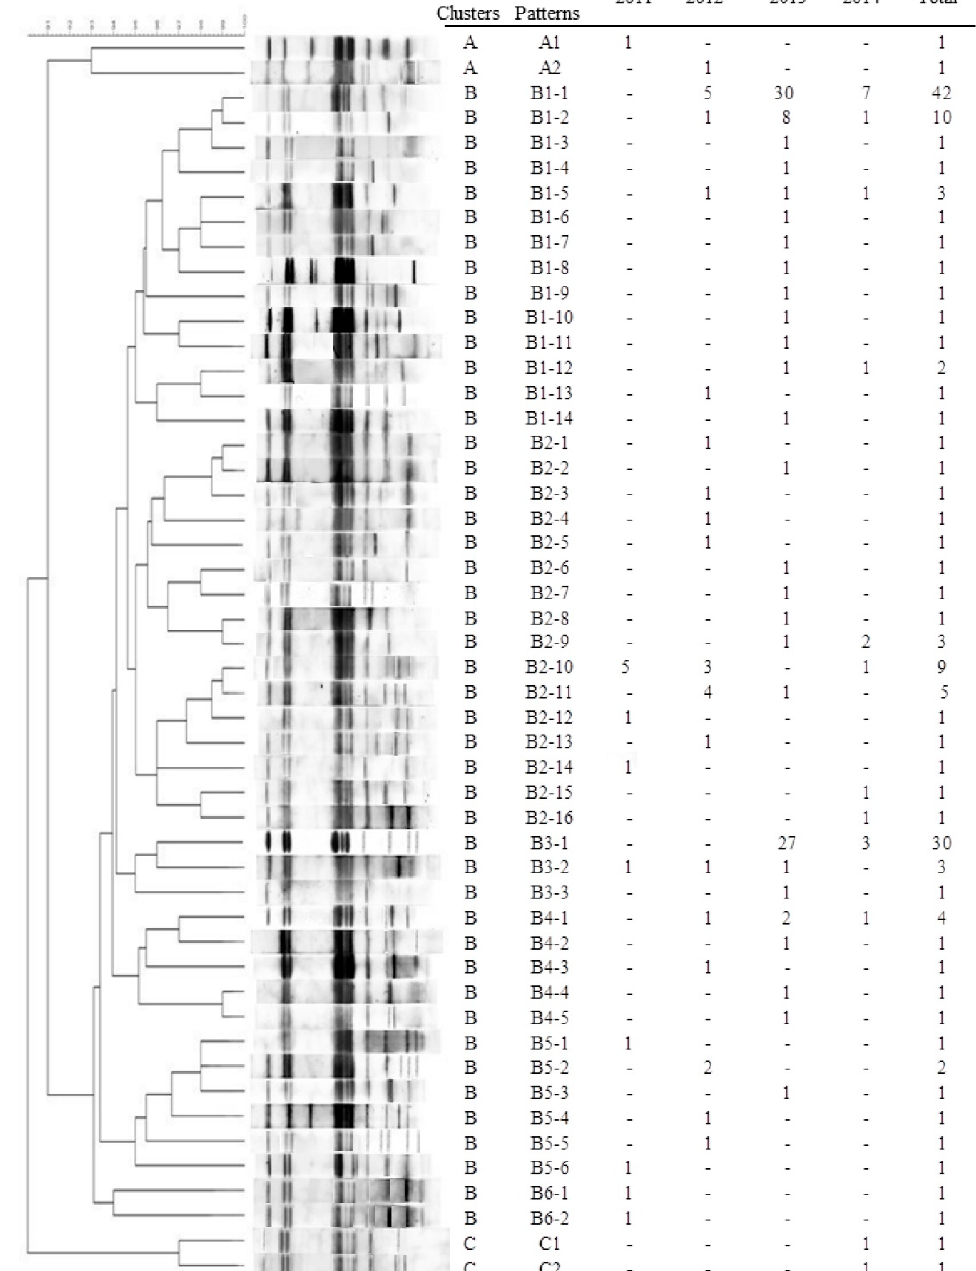
Figure 5. Dendrogram of patterns generated by pulsed-field gel electrophoresis (PFGE) of 152 bla CTX-M-55 -postitive S. Enteritidis isolates. Xba I was used as the PFGE restriction enzyme. The data in columns 2011, 2012, 2013, and 2014 are the number of isolates from which each pattern was recovered.